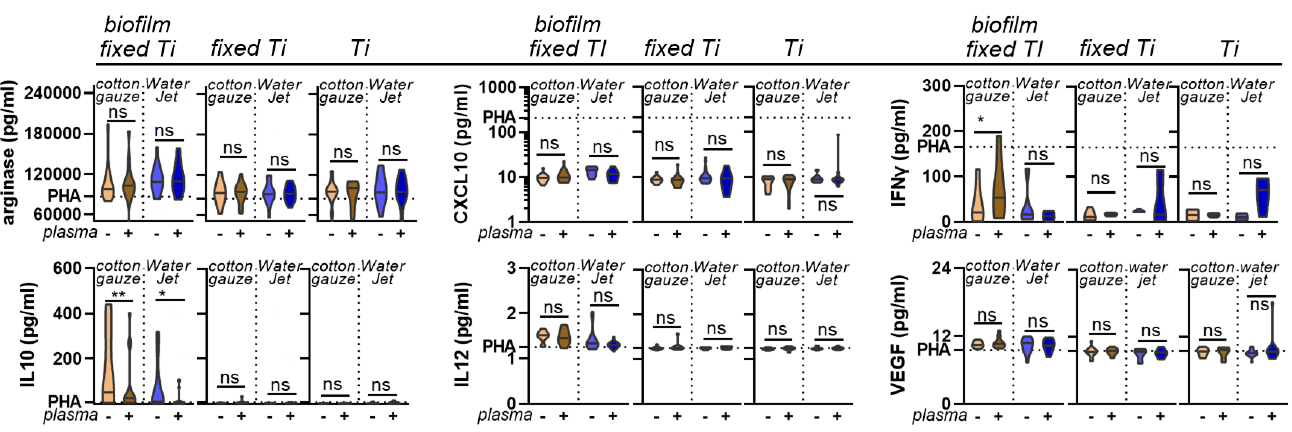
Figure A3. Chemokine and cytokine analysis. Absolute analyte concentrations across cotton gauze and WaterJet ±CAP conditions and PHA (dotted line) as reference of leukocyte culture supernatants incubated with contaminated titanium discs (biofilm fixed TI), clean titanium discs exposed to fixative only (fixed Ti), and titanium discs only (no fixation). Data are from four donors and show violin plots and median. Statistical analysis was performed using paired t -test; * = p < 0.05, ** = p < 0.01, ns = not significant. PBMC from four different donors were tested. Biofilm was generated from subgingival plaque of a single periodontally diseased individual.